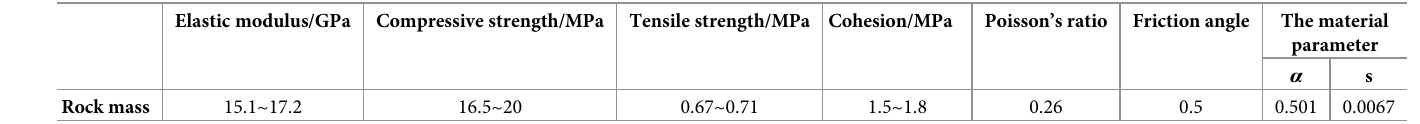
Table 1. Macro parameters of the rock mass.